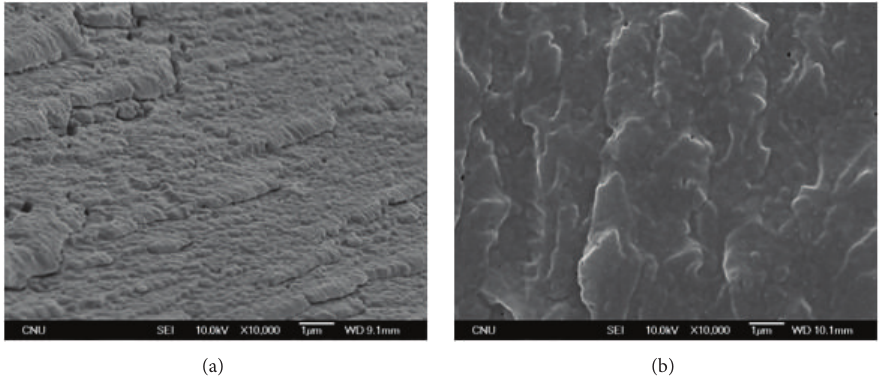
Figure 9: SEM photographs of surface of (a) SPI/glycerol without PVA, (b) SPI/glycerol film with PVA.